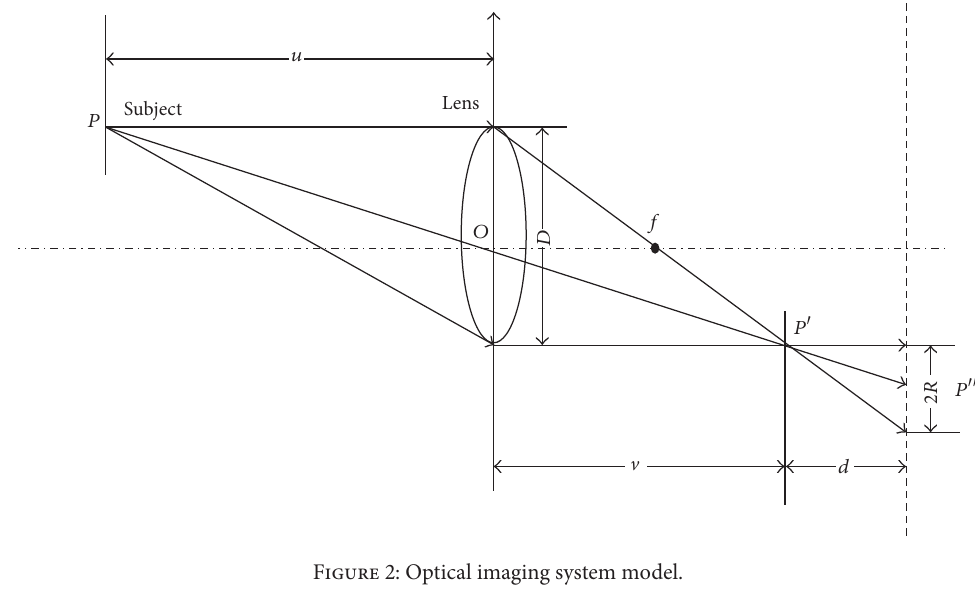
Figure 2: Optical imaging system model.